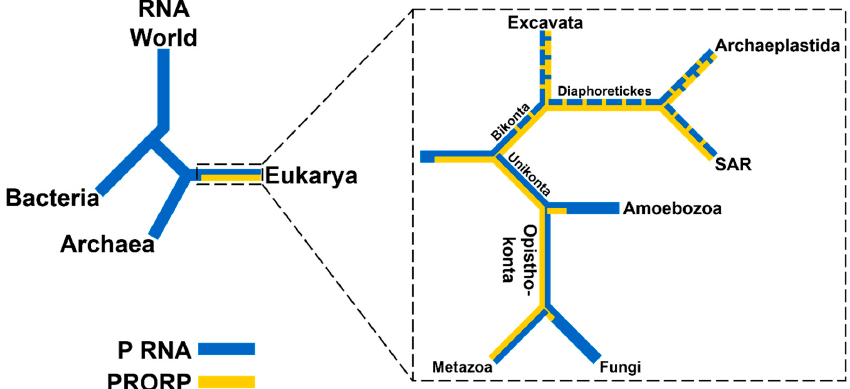
Figure 2. Distribution of RNase P enzymes across evolutionary lineages. Presence of a P RNA (blue) or PRORP (yellow) is indicated. Left : RNA ‐ based RNase Ps are found in all domains of life and are proposed to have evolved from an RNA predecessor lacking protein components. PRORPs exist only in Eukarya and likely evolved after the divergence with Archaea. Right : Distribution of RNase Ps in Eukarya using the five supergroup model (aspects of the branching order remain controversial) [12,13]. PRORPs are found in four supergroups: Excavata, Archaeplastida, SAR [Stramenopiles, Aveolata, and Rhizaria], and Opisthokonta, but not in the fifth: Amoebozoa [11]. Dashed blue or yellow lines indicate that some clades within the supergroup lack RNase P RNA or PRORP sequences, respectively.